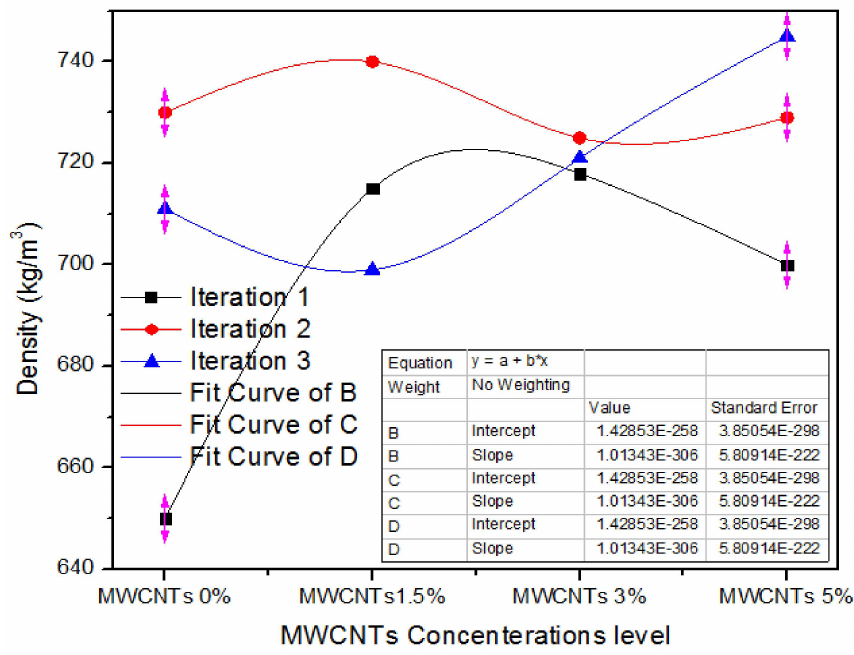
Figure 7. Statistical values of density of MDF for various concentrations of